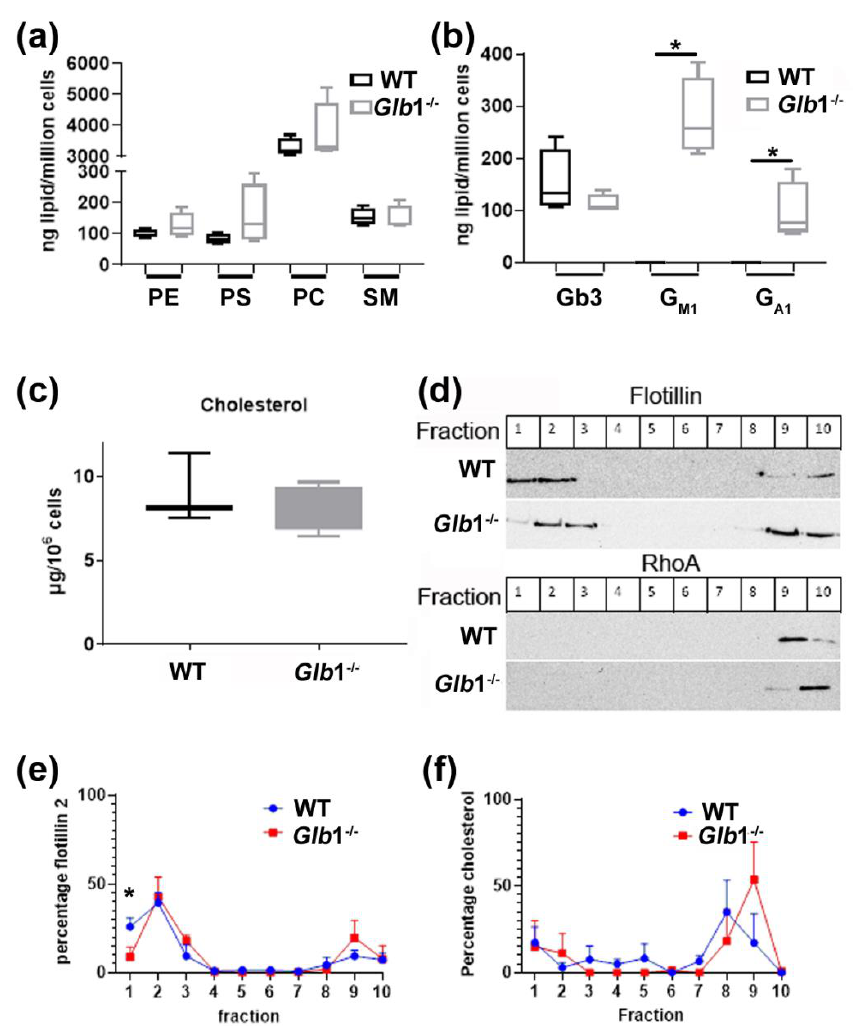
Figure 8. Biochemical characterization of fibroblasts. ( a ) TLC analysis of 3.5 to five-month-old Glb1 − / − and wildtype (WT) fibroblasts for phosphatidylserine (PS), phosphatidylcholine (PC) and sphingomyelin (SM); ( b ) presence of Gb3, G M1 and G A1 in Glb1 − / − mice and Gb3 in WT mice; ( c ) cholesterol concentration in WT and Glb1 − / − mice determined by HPLC; ( d ) Western blot of sucrose density gradient fractions for flotillin 2 and RhoA; ( e , f ) HPLC analysis of the same fractions for flotillin 2 and cholesterol distribution. * p < 0.05. Box plots are used to show data; n = 4.